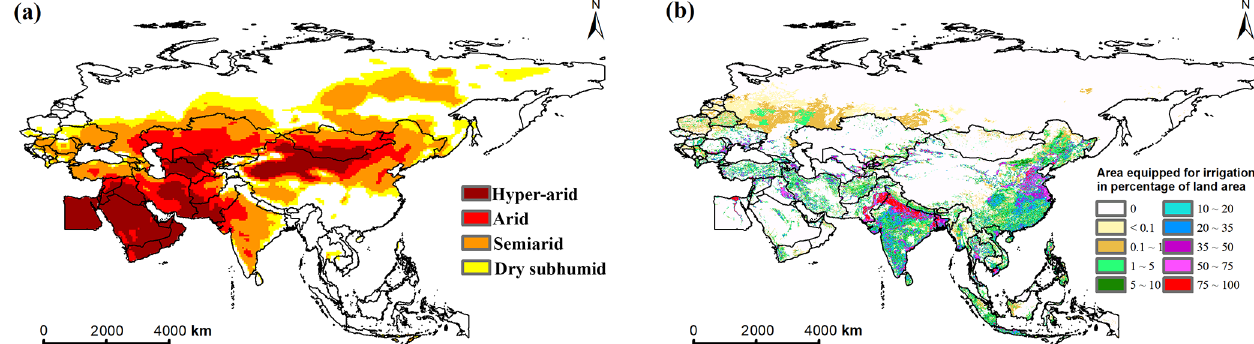
Figure 1. Boundaries of the Asian and eastern European regions. Panel (a) is the spatial distribution of arid and semiarid areas based on the averaged aridity index during 2002–2017. The aridity index is calculated based on the ERA-Interim dataset downloaded from the European Centre for Medium-Range Weather Forecasts. Panel (b) is the percentage area of irrigated land across the study area. The percentage area of irrigated land dataset is derived from the Food and Agriculture Organization of the United